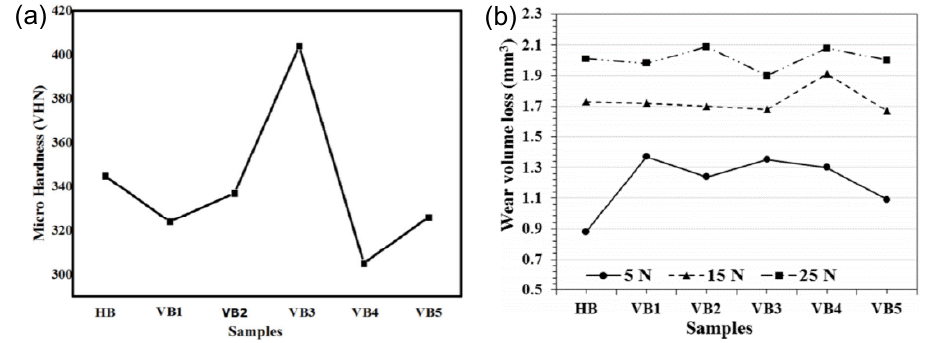
Figure 18. ( a ) Microhardness of horizontal and vertical built specimens, ( b ) Wear performance of horizontal and vertical built specimens. Reproduced from [5], with permission from Elsevier, 2018.